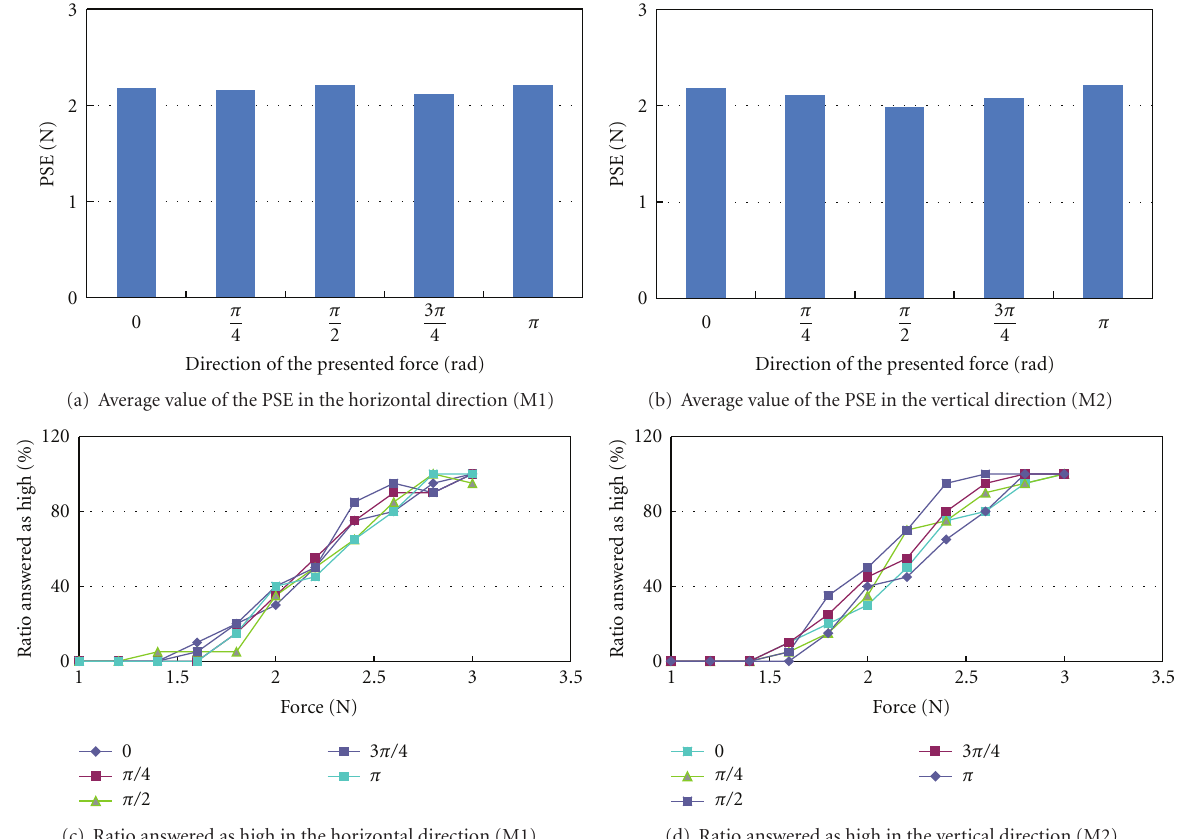
Figure 12: Measurement results of the PSE.